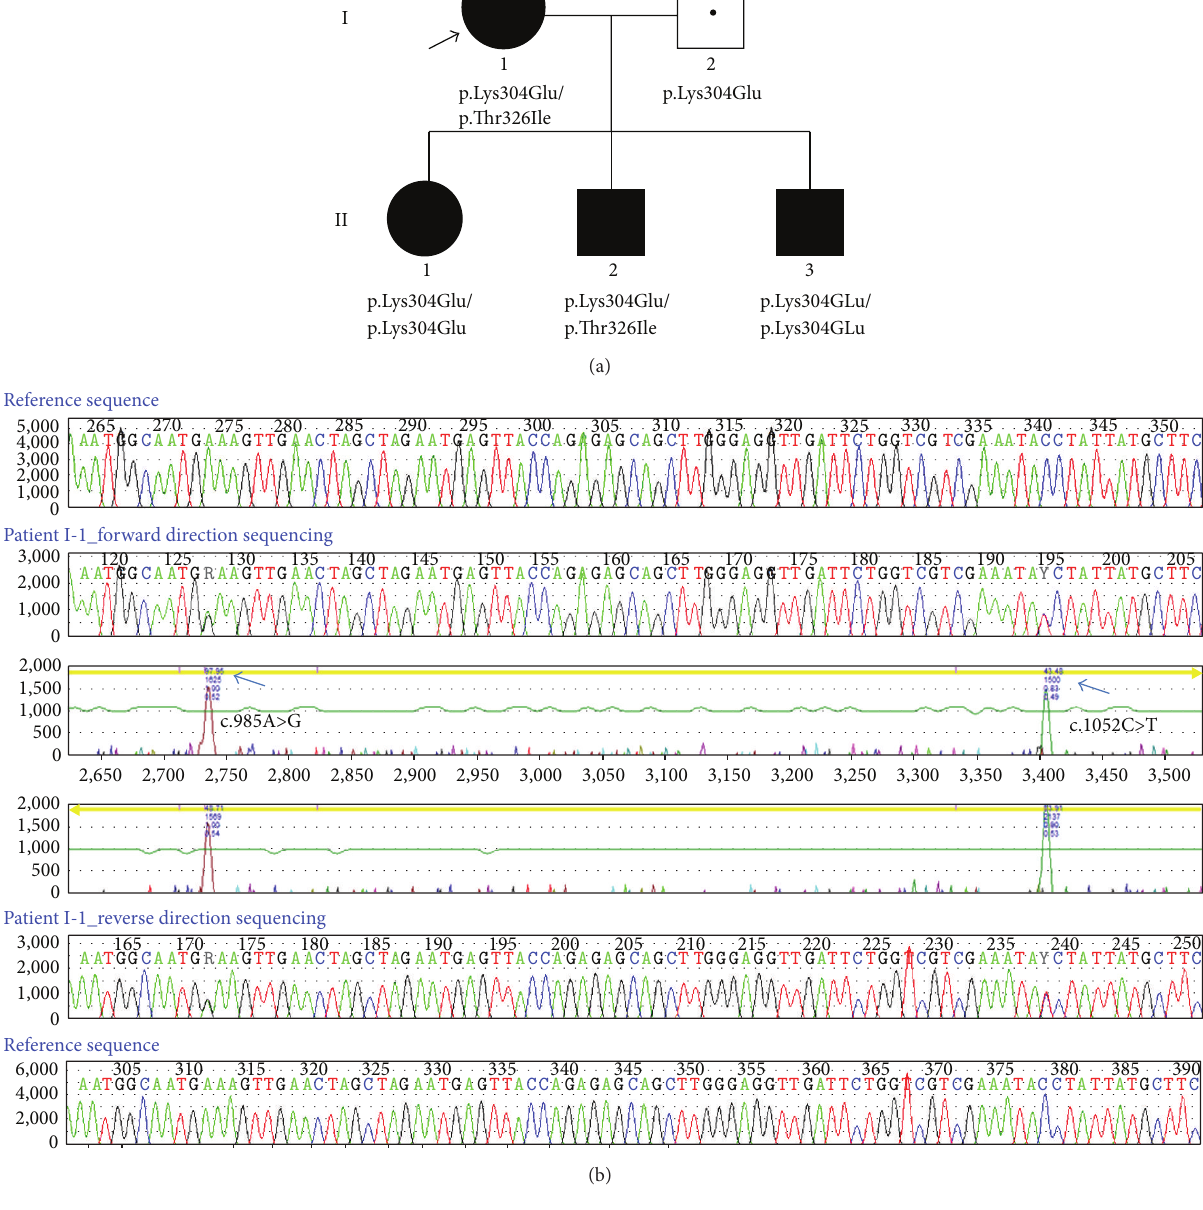
Figure 1: Novel MCADD mutation. (a) MCADD family pedigree. The proband (I-1) is indicated by a black arrow. The father (I-2) is a carrier as indicated by the dot in the center of the square. All affected individuals are indicated by filled circles (females) or squares (males). (b) DNA sequencing results. ACADM sequence analysis revealed a heterozygous sequence change of c.1052C > T, p.Thr326Ile in addition to the common mutation p.Lys304Glu in patient I-1. Blue arrows indicate the sequence change in patient